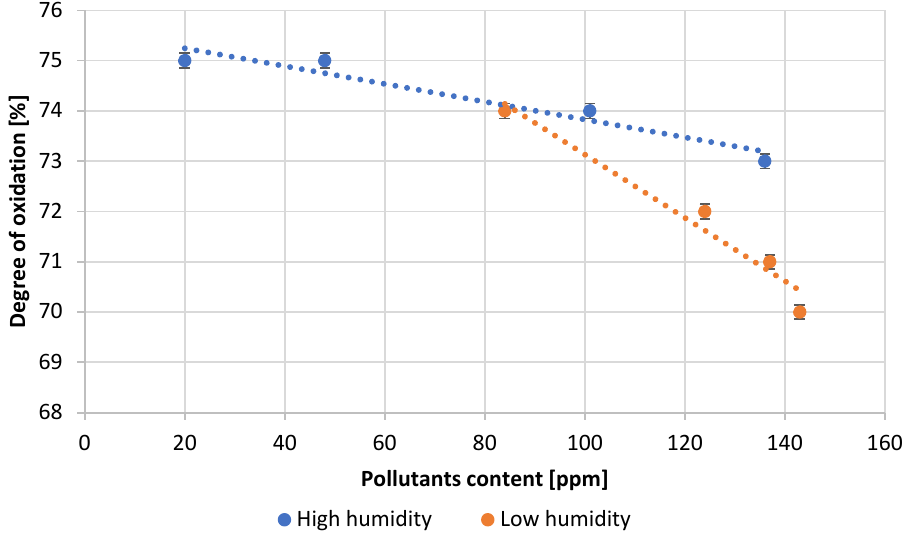
Figure 10. Dependence of the degree of lead oxidation on pollutants content.